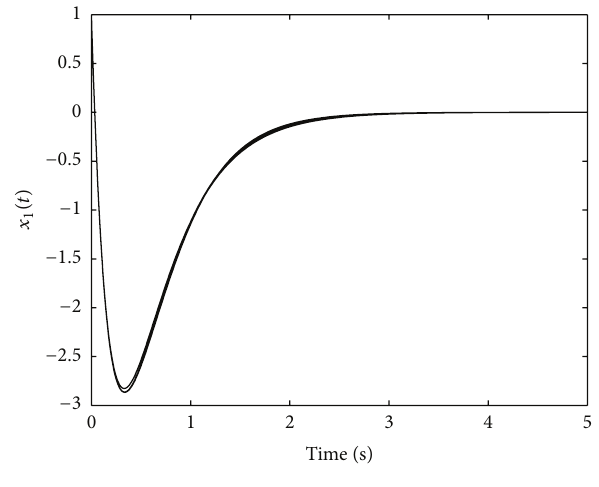
Figure 1: Evolution of the state variable 𝑥 1 (𝑡) .